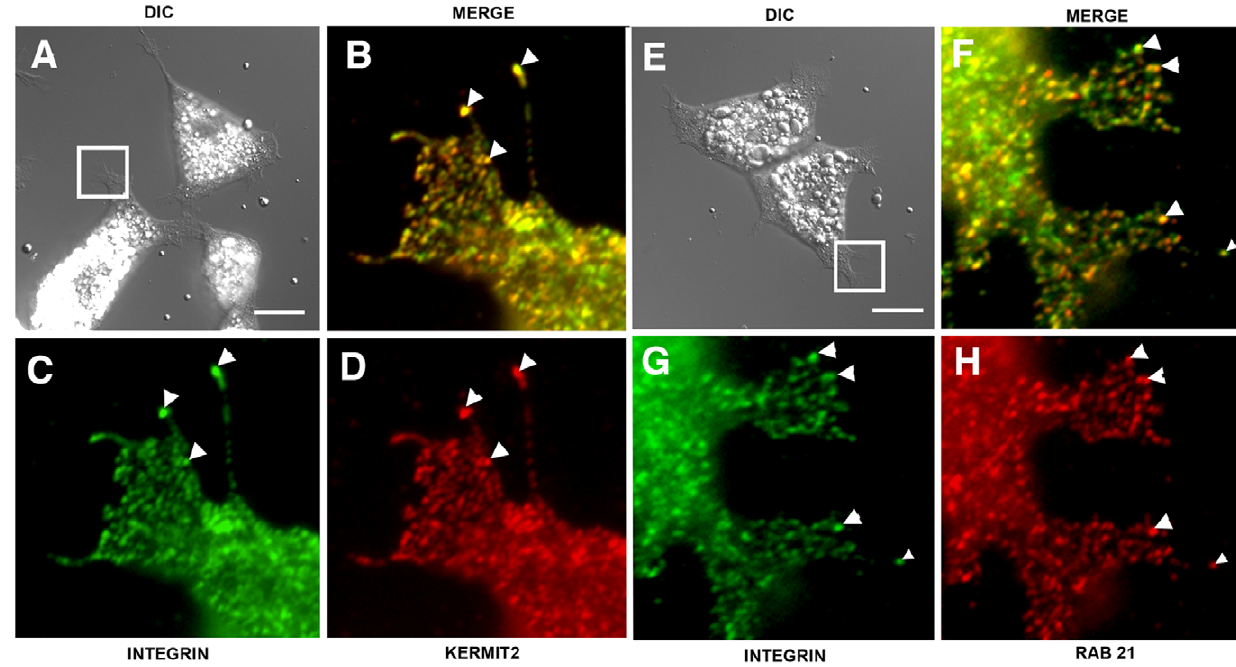
Figure 10. Colocalization of a 5 b 1, kermit2, and Rab 21 in Xenopus embryonic cells. Activin-treated embryonic cells were plated on FN substrates and stained for a 5 b 1 (green), or kermit2 (red D), or Rab 21 (red H). (A, E) DIC images of adherent cells, boxes represent areas magnified in B–D and F–H. (A–D) Integrin (C; green) and kermit2 (D; red) colocalize at sites of adhesion (arrowheads in B–D). (E–H) Rab 21 (H; red) and integrin (G; green) colocalize in embryonic cells (arrowheads in F–H). Staining of cells with secondary antibodies alone produced no detectable signal. Size marker =25 m M.